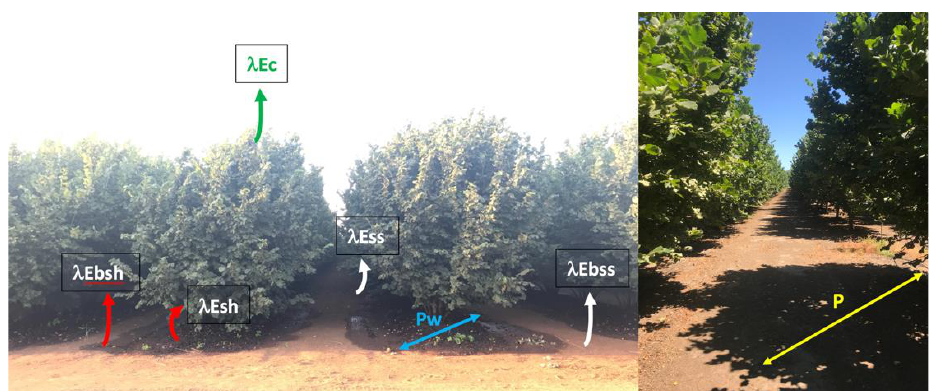
Figure 3. Schematic of latent heat flux from canopy and soil. λEc, λEbs, and λEs are the latent heat from the canopy, the bare soil between rows, and the soil below the canopy, respectively. The last letter in λEbs and λEs indicate non -wetted (s) and wetted soil (h).